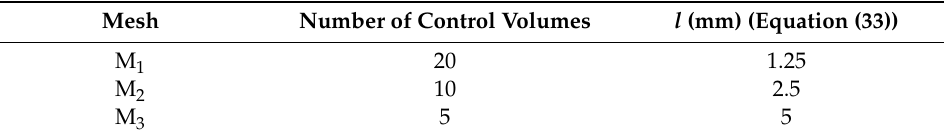
Table 4. Details of the meshes used in the mesh refinement study.